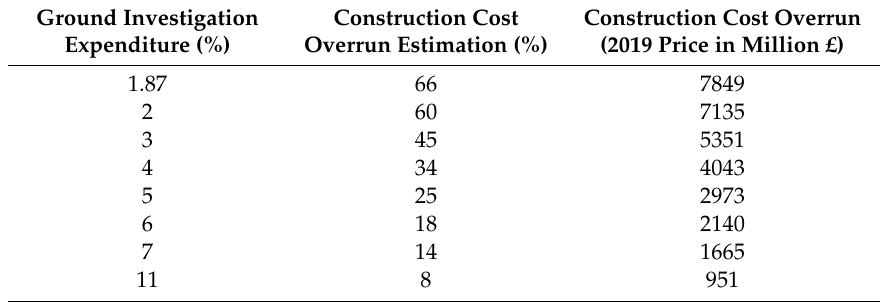
Table 8. Estimation of overruns of the project cost with floating expenditure in ground